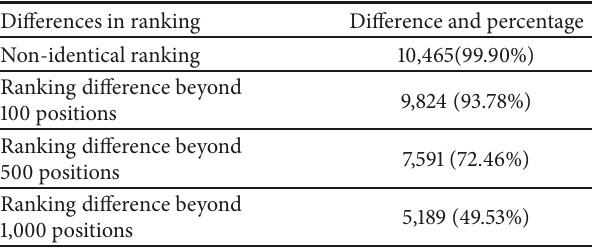
Table 5: Modelling results of carcass removal for NB models with the Washington data.